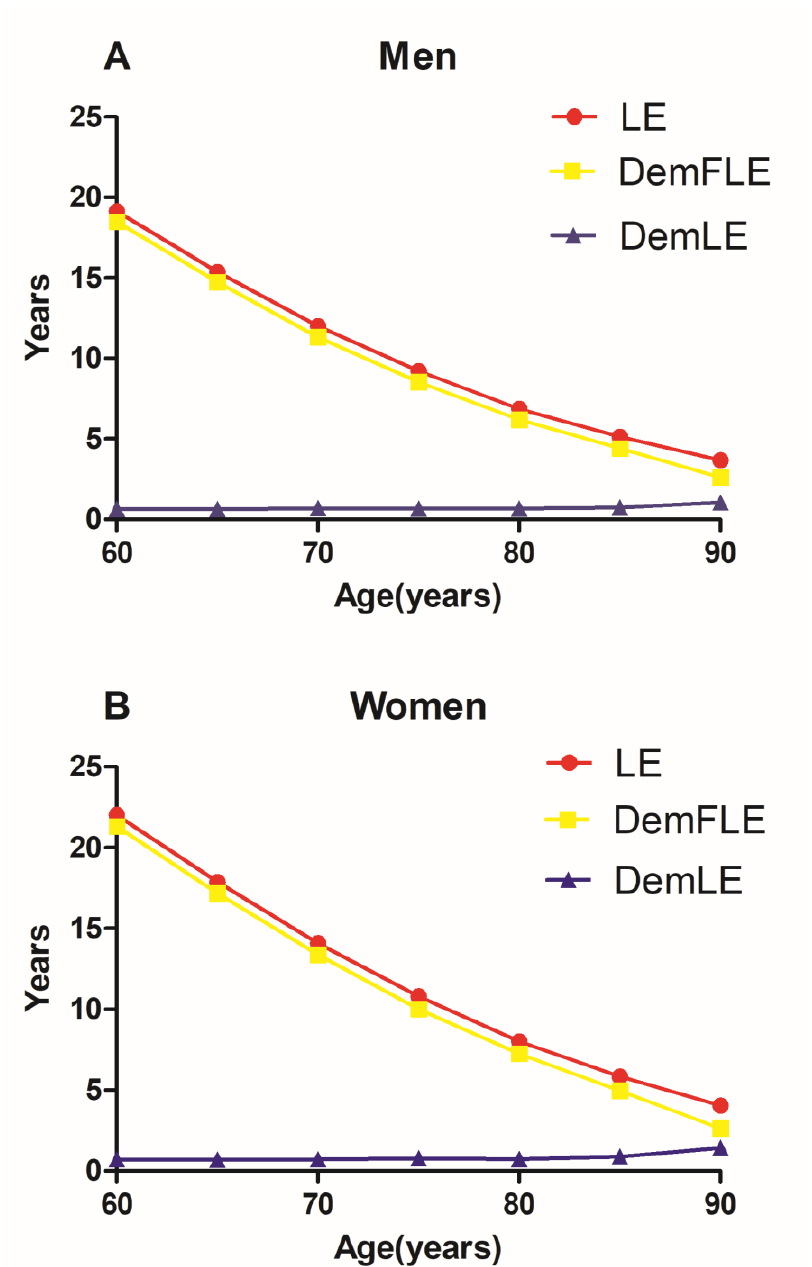
Figure 1. Trends of life expectancy (LE), dementia-free life expectancy (DemFLE), and life expectancy with dementia (DemLE). A. Men B. Women.